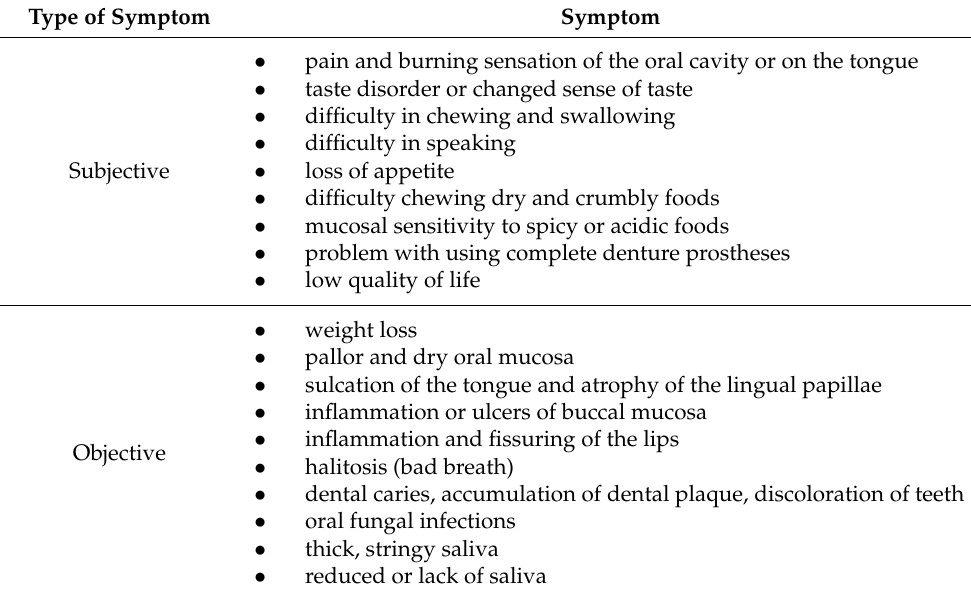
Table 2. Symptoms of